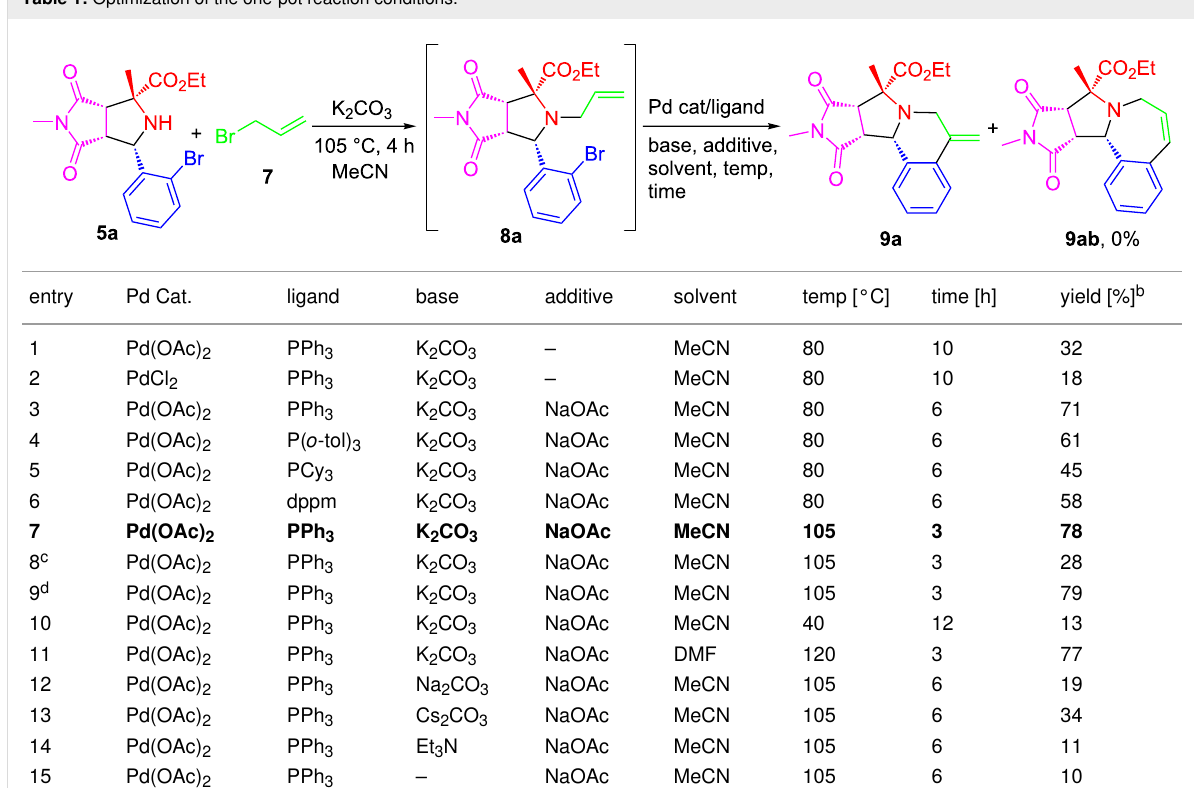
product 9a in 32% and 18% yields, respectively (Table 1, entries 1 and 2). Addition of NaOAc increased the yield of 9a to 71% (Table 1, entry 3). Other attempts to improve the Heck reaction using different ligands, such as (P( o -tol) 3 , PCy 3 and dppm, were not successful (Table 1, entries 4–6). The reaction at 105 °C in MeCN gave 9a in 78% yield (Table 1, entry 7), while at 120 °C in DMF gave 9a in 77% yield (Table 1, entry 11). Reducing the amount of Pd(OAc) 2 to 5 mol % or the